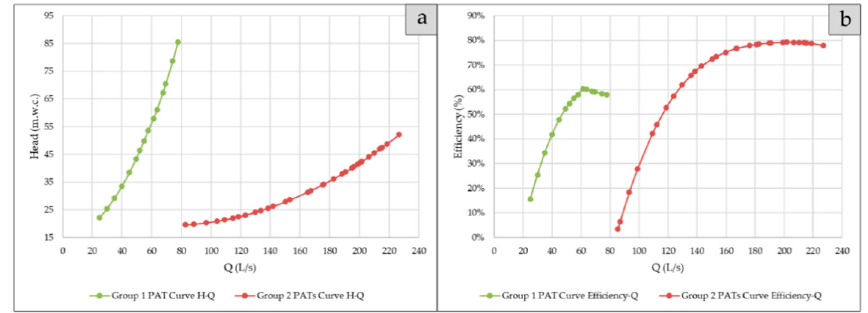
Figure 9. ( a ) Curve Q-H for the selected PATs from group 2. ( b ) Curve Q-efficiency for the selected pumps from group 2.